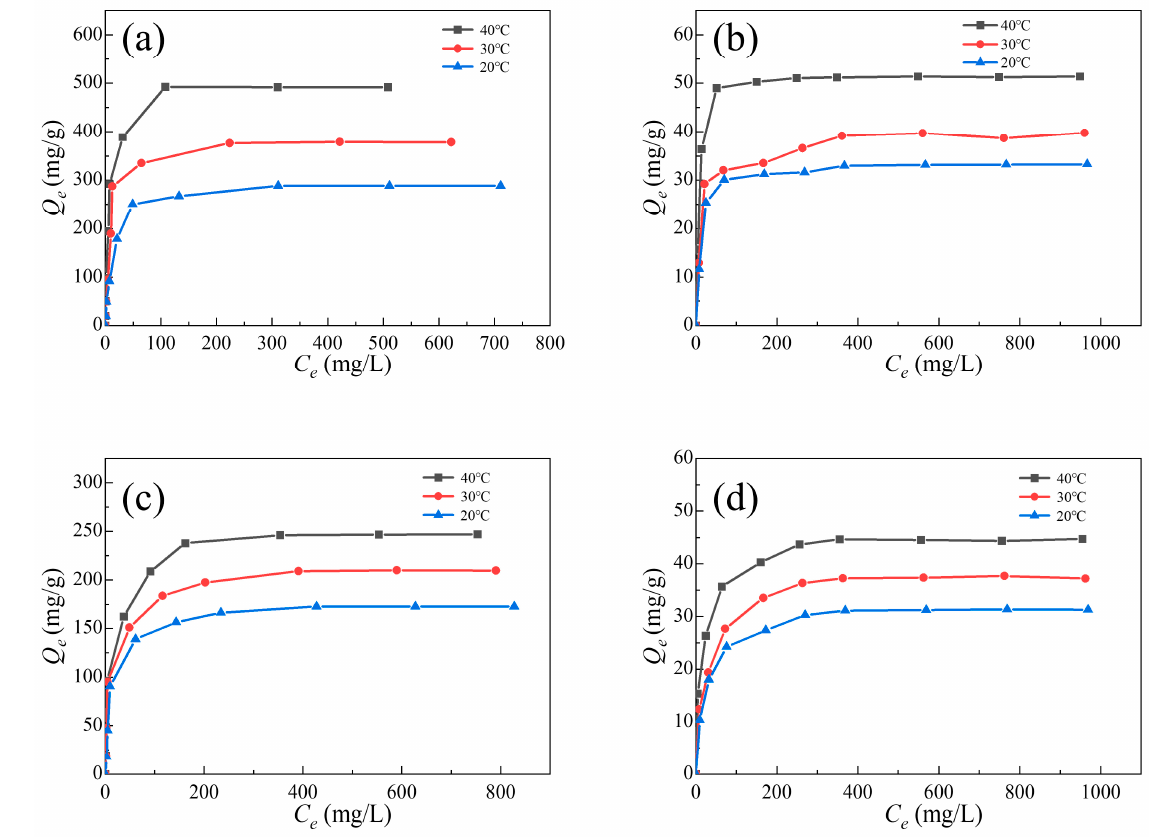
Figure 8. ST and MB adsorption isotherms in ( a , c ) Al 0.3 Zr 0.7 -UiO-66 and ( b , d ) UiO-66. Adsorption isotherms of ST and MB on UiO-66 and Al 0.3 Zr 0.7 -UiO-66 were fitted using Langmuir, Freundlich, and Henry models (Figures S7 and S8, and Table 4). The Henry model and Freundlich model describe the adsorption isotherm with low R 2 values, while the Langmuir model fits the data well, indicating that the adsorption of dyes on UiO-66 and Al 0.3 Zr 0.7 -UiO-66 could be a monolayer on the uniform surface. Table 4. Parameters of two isotherm models for ST and MB adsorption on UiO-66 and Al 0.3 Zr 0.7 -UiO-66.